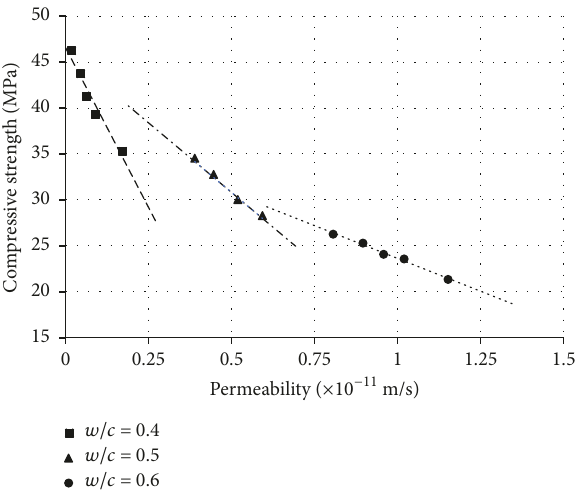
Figure 4: Comparative water permeability of brick and stone aggregate